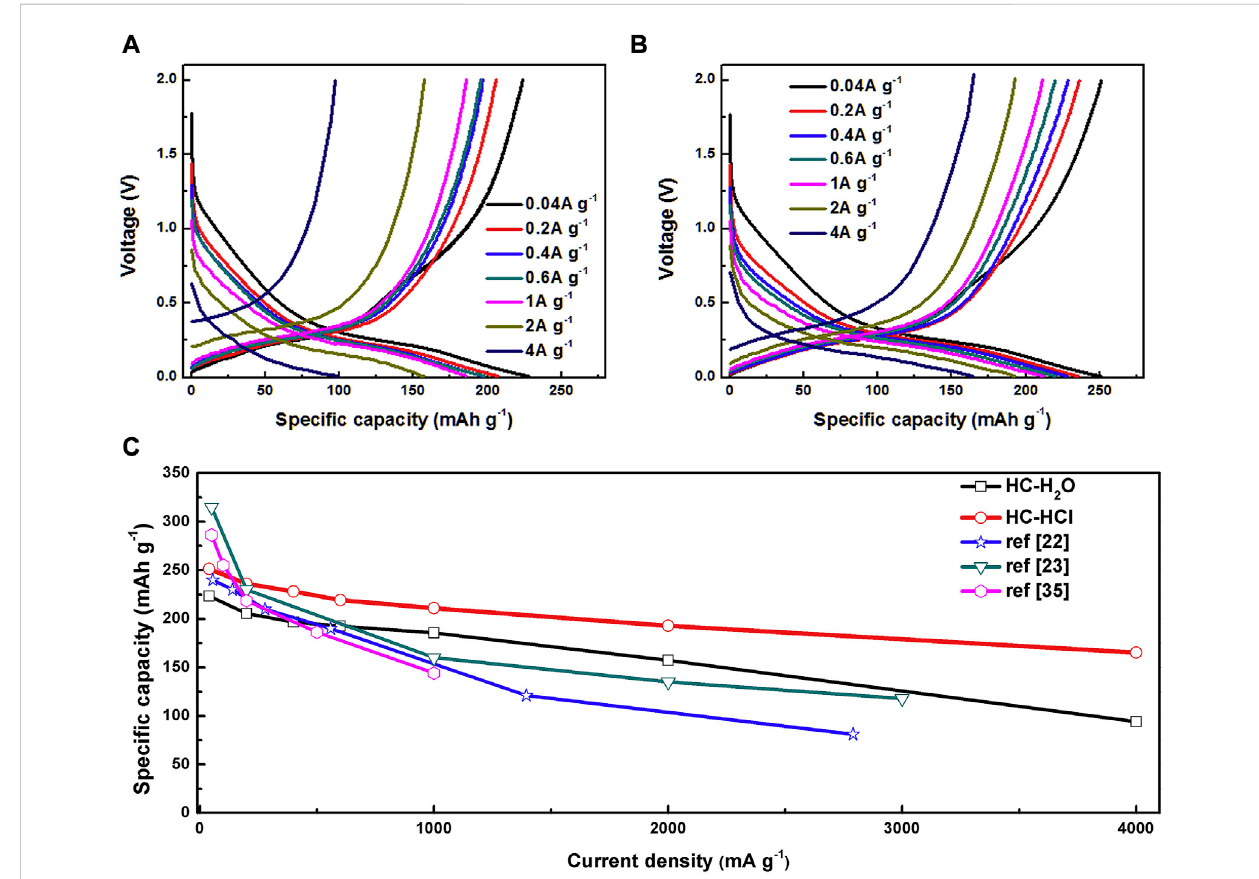
FIGURE 5 Magni fi cation performance: (A) HC – H 2 O and (B) HC – HCL; (C) comparison with the literature (He, et al.,